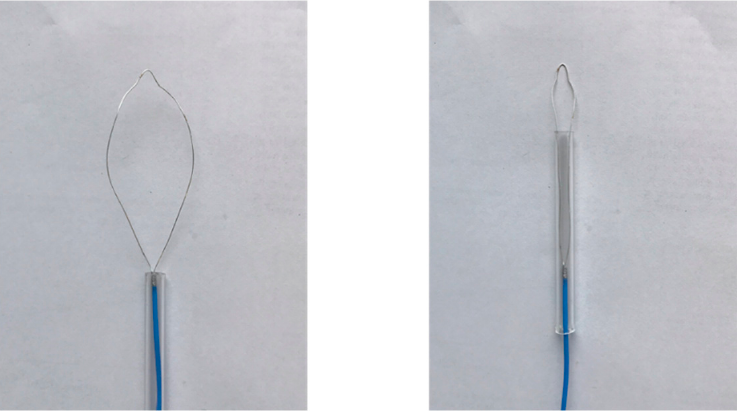
Figure 10. Prototype device.